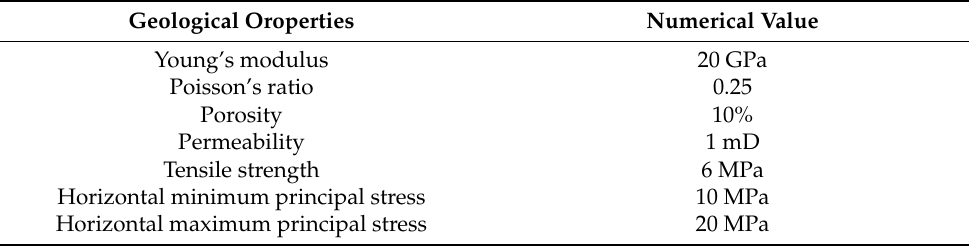
Table 1. Stratigraphic properties.